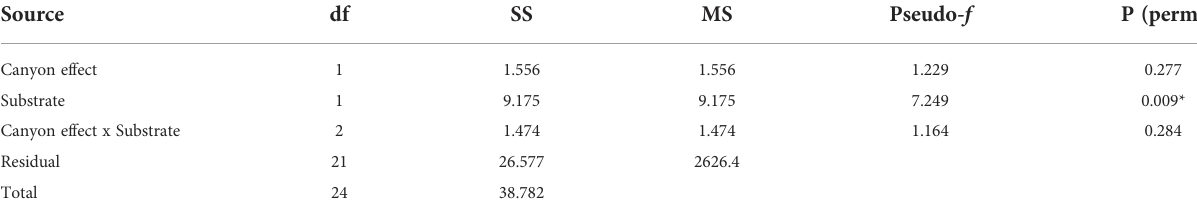
TABLE 1 PERMANOVA, Type1 (sequential) fi xed effects on a permutation of residuals under a reduced model (9999 number of permutations), results of diversity measures in substrate groups represented in the canyon and non-canyon stations - where * shows signi fi cant values. Source df SS MS Pseudo- f P (perm)